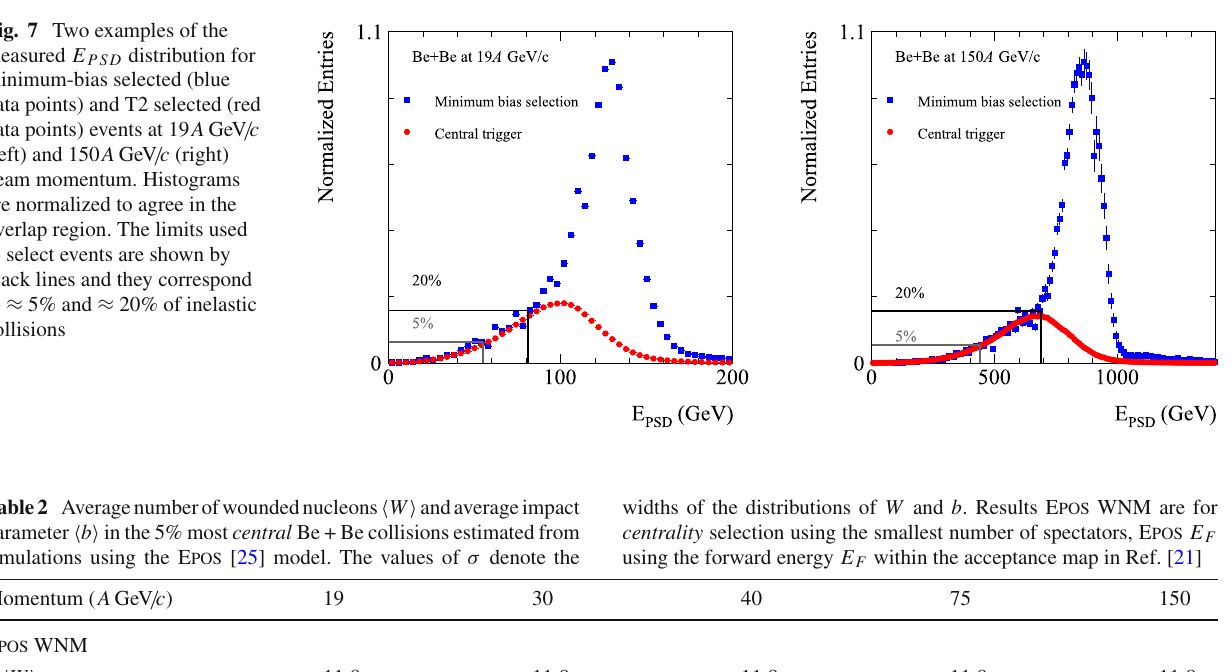
Fig. 7 Two examples of the measured E PSD distribution for minimum-bias selected (blue data points) and T2 selected (red data points) events at 19 A GeV / c (left) and 150 A GeV / c (right) beam momentum. Histograms are normalized to agree in the overlap region. The limits used to select events are shown by black lines and they correspond to ≈ 5% and ≈ 20% of inelastic collisions